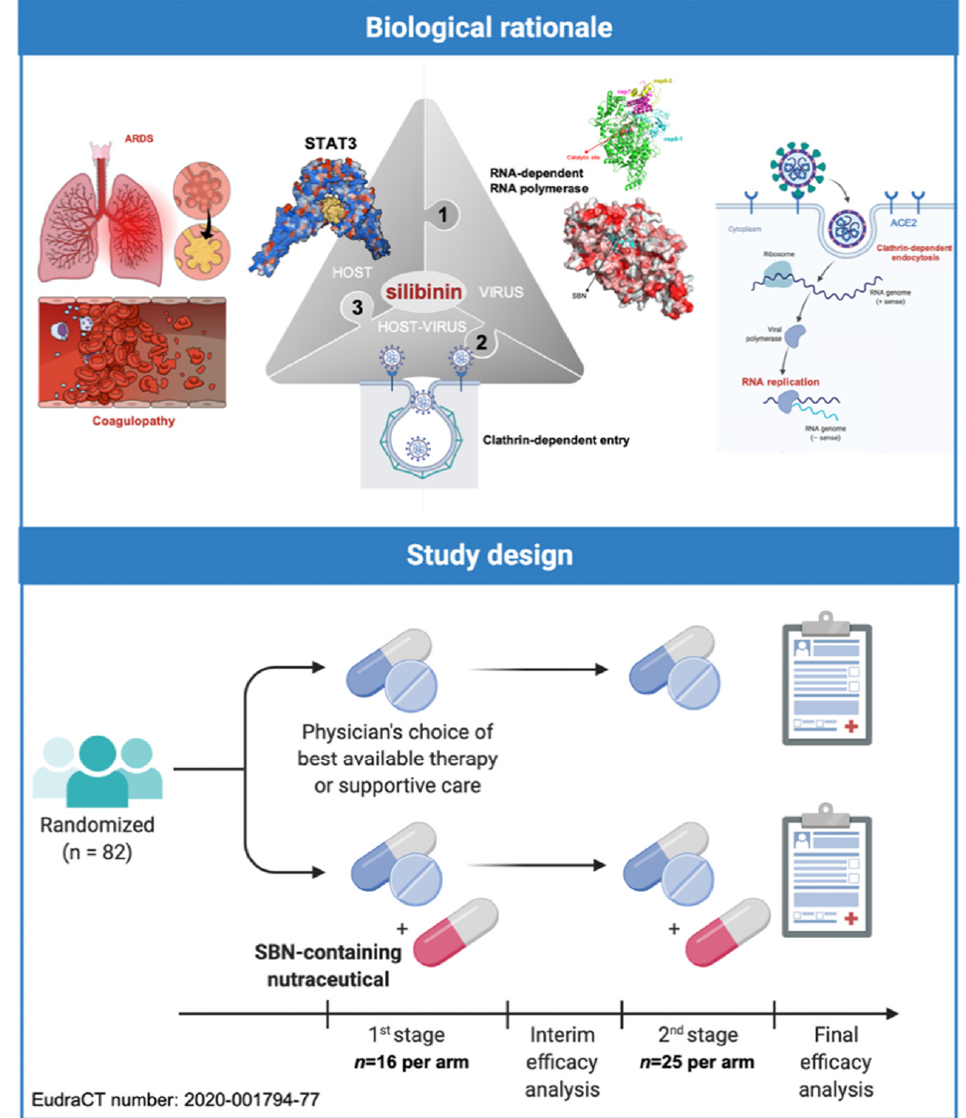
Figure 4. The SilCOVID-19 trial: Biological rationale and study design. The SilCOVID-19 study is a phase II clinical trial to evaluate the efficacy of silibinin supplementation in the prevention of the respiratory failure progression in patients with active cancer disease and infection by SARS-CoV-2. Created with Biorender.com and